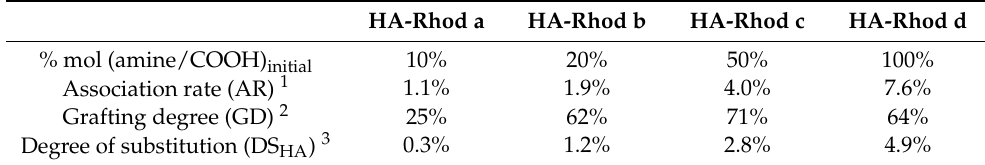
Table 4. Degrees of substitution of HA functionalized with rhodamine.